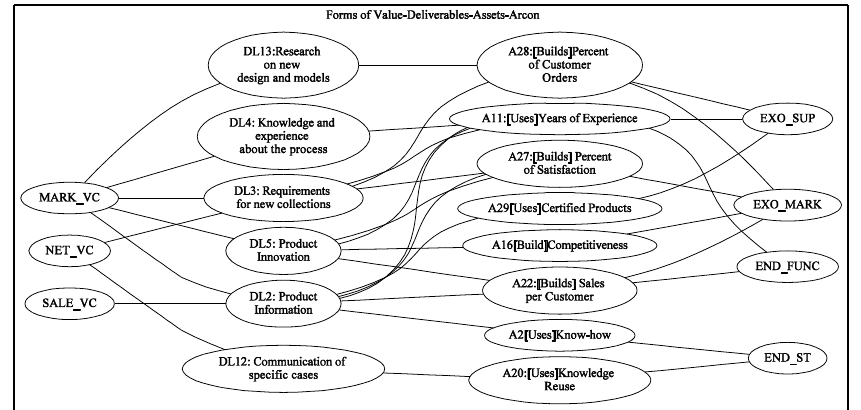
Fig. 6. Map of Emerging Relationships: Forms of Value, Deliverables, Enterprise Assets